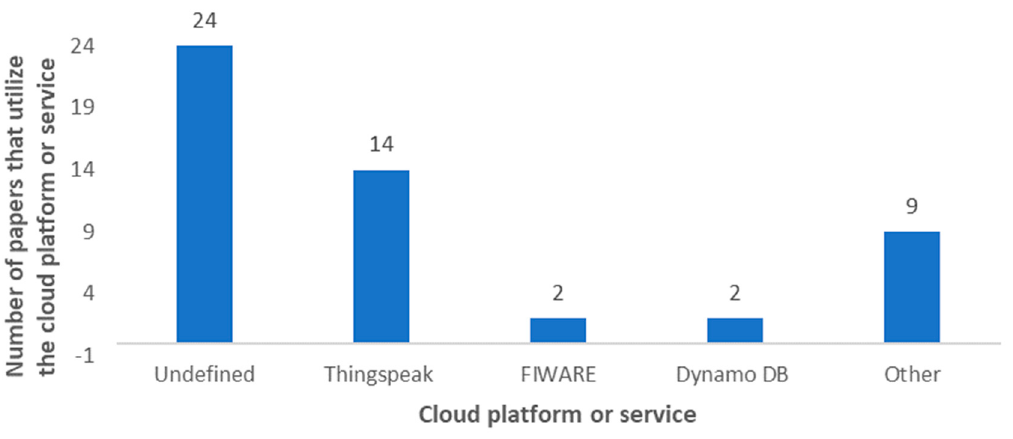
Figure 27. Number of papers that employ each clouds service or platform. Table 8. Cloud platforms.